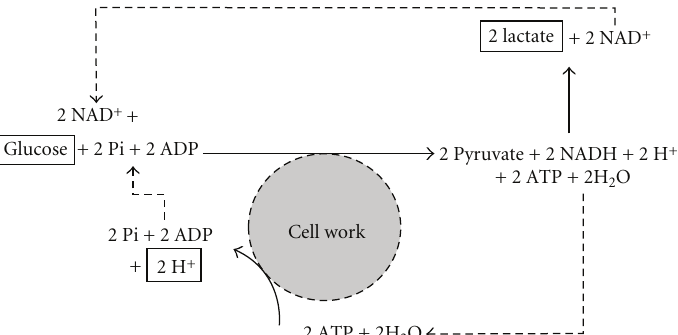
Figure 11: The changes and cycling of substrates, products, and protons during the glycolytic-lactate energy system. Adapted from Robergs et al. [45].